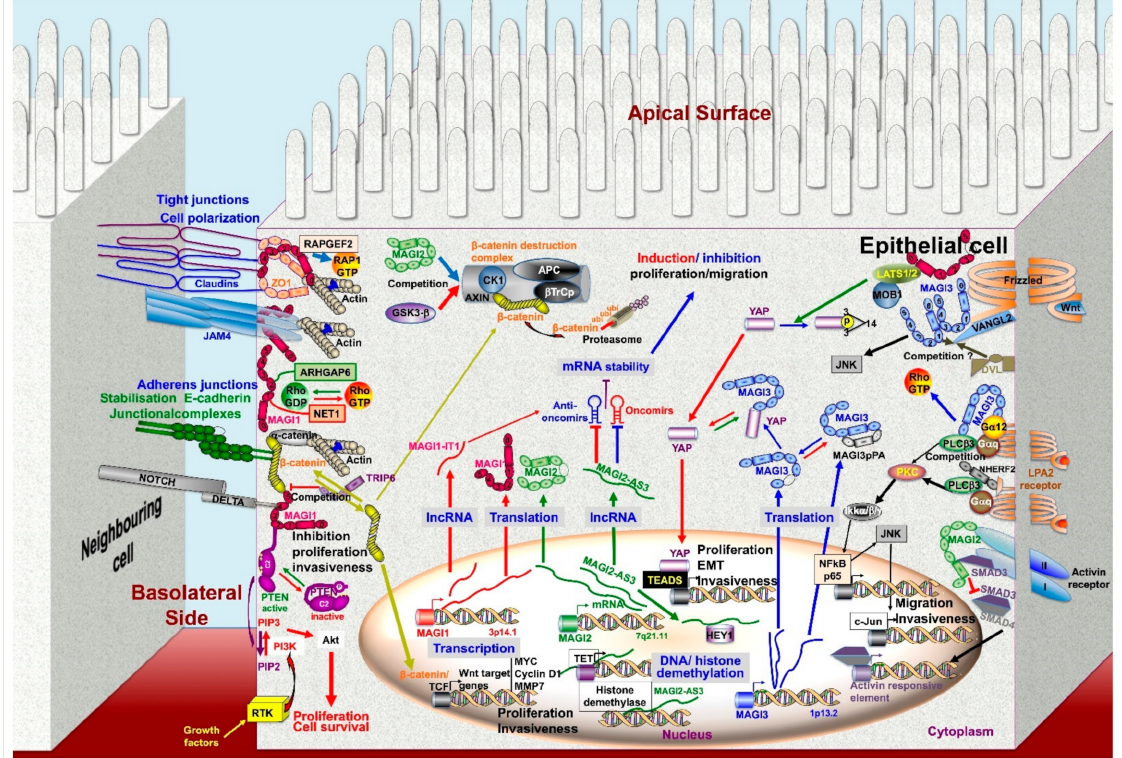
Figure 5. Schematic overview of MAGI signaling dysregulation in cancer, at the levels of MAGIs themselves (transcription, RNA maturation, post-translational modifications), of their interacting partners and effectors systems including signalization, gene expression and epigenetics, and the biological impact of these dysregulations. For details see the